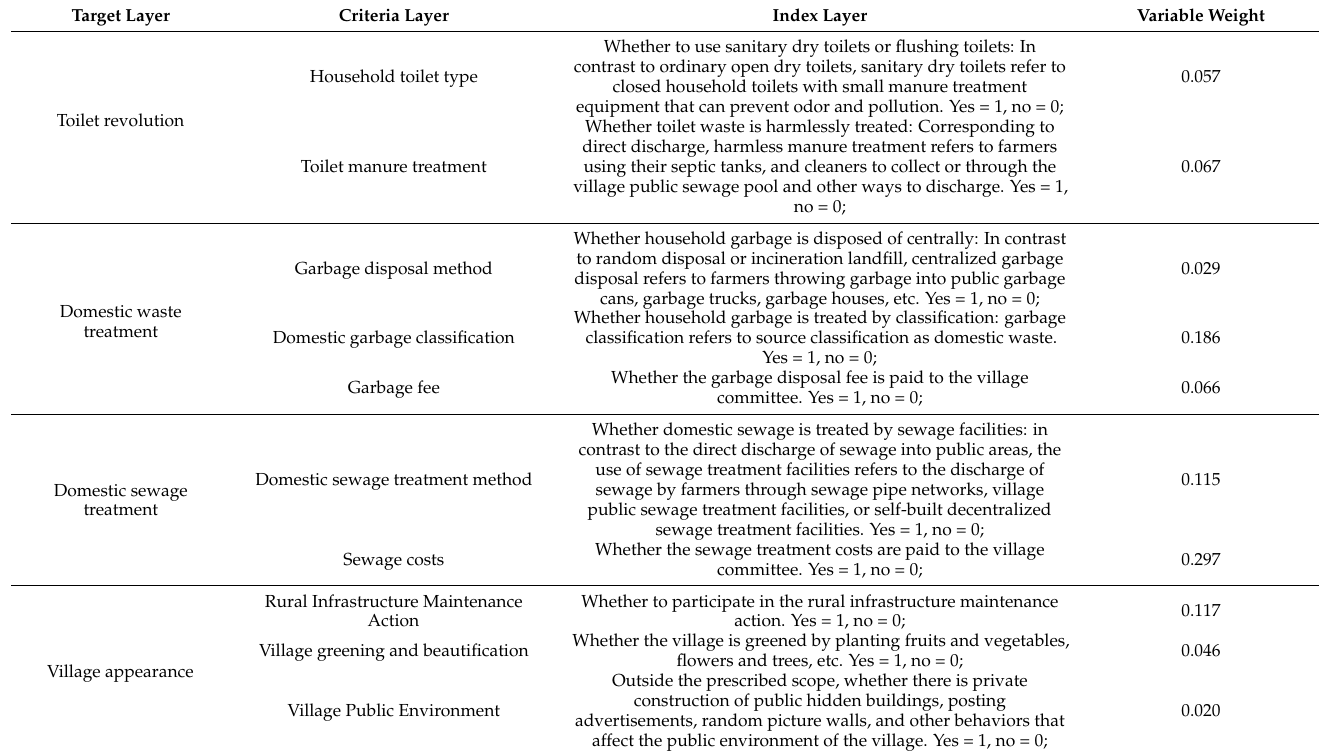
Table 1. Evaluation index institutions of farmers’ participation in RRE.